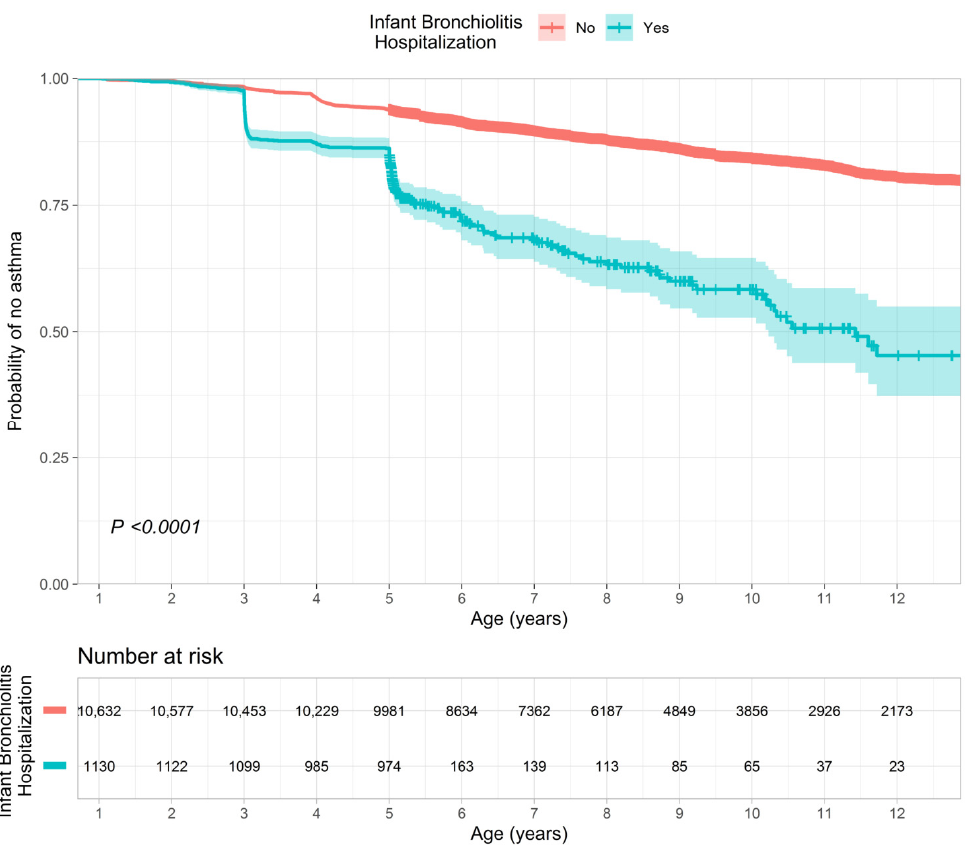
Figure 1. Kaplan–Meier curves for developing childhood asthma, according to bronchiolitis hospi- talization (severe bronchiolitis).